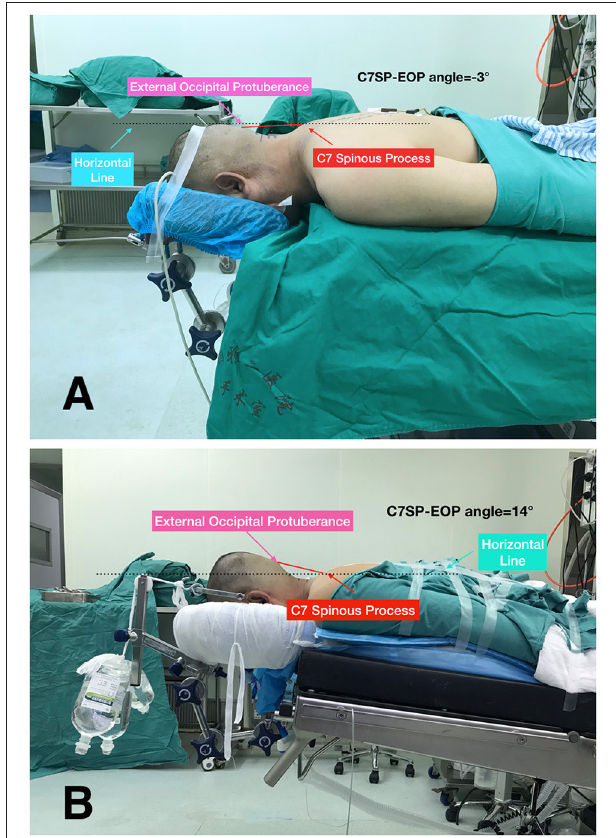
FIGURE 4 | The angle between the C7 spinous process-external occipital protuberance line and horizontal line (C7SP-EOP angle) was defined as a system to evaluate the degree of surgeon comfort during the operation. The traditional position is assessed at level 1 (A) , while the BSPST position at level 4 (B)